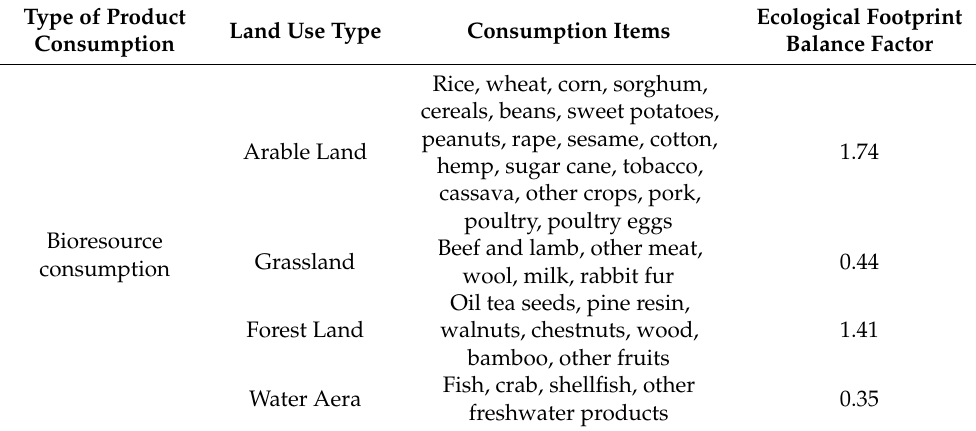
Table 2. Ecological footprint model indicator evaluation